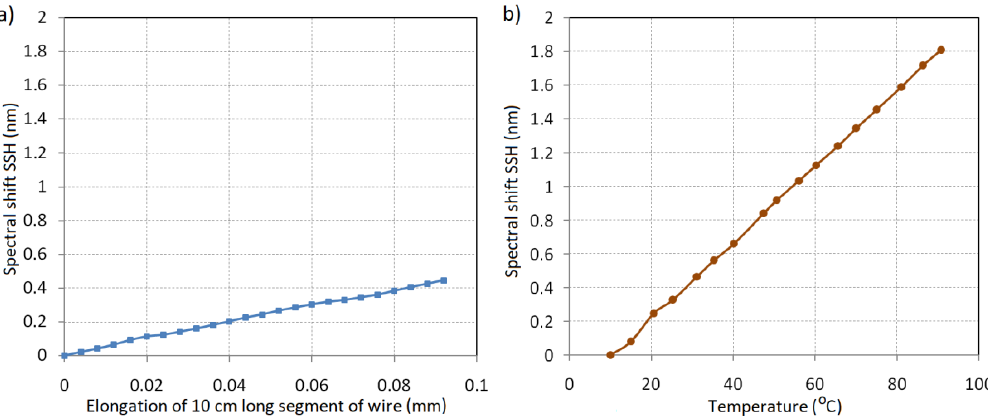
Figure 8. The comparison of SSH dependency on ( a ) the elongation of the testing plate; and ( b ) the changes of the CFBG sensor surrounding temperature.